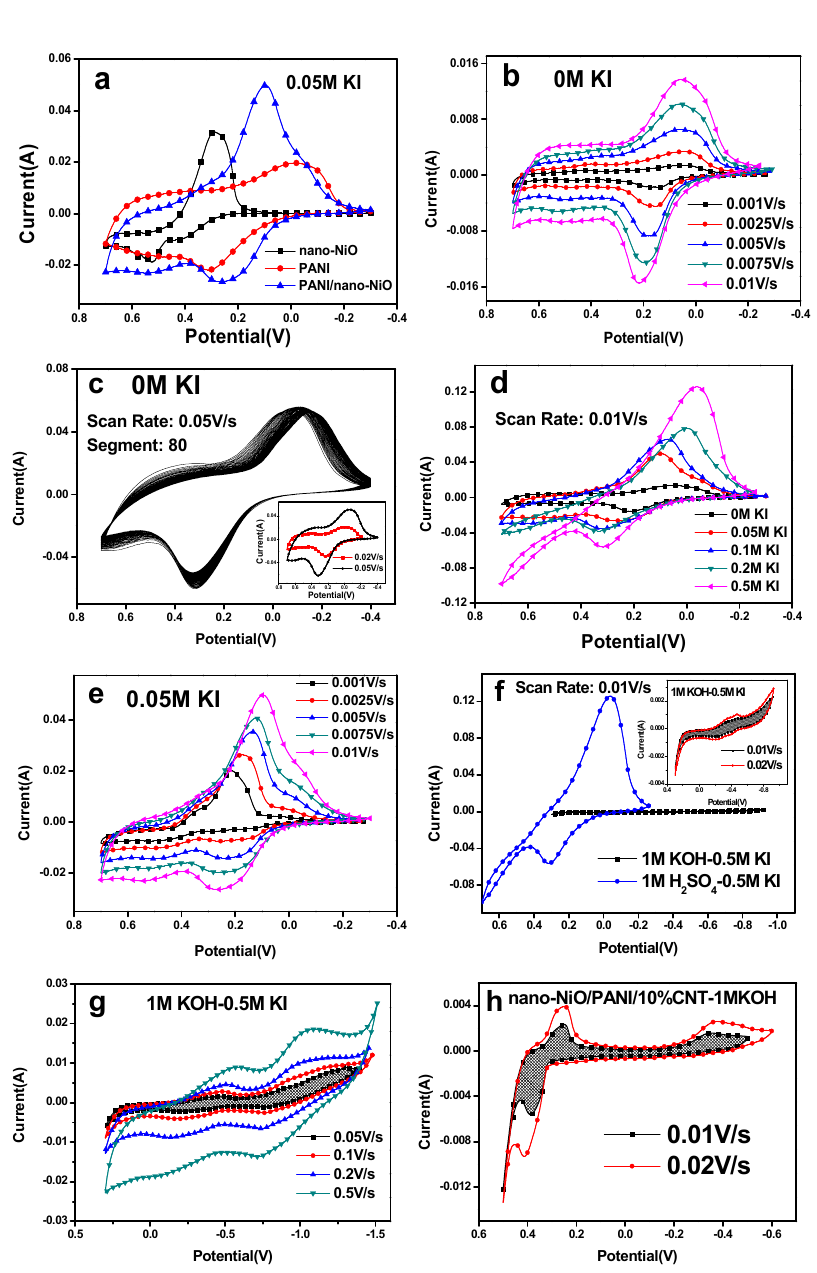
Figure 6. CV curves in different electrolytes, scan rates and concentration of KI. ( a ) 0.05 M KI, 0.01 V/s. ( b ) 0 M KI, 0.001–0.01 V/s. ( c ) 0 M KI, 0.05 V/s. ( d ) 0–0.5 M KI, 0.01 V/s. ( e ) 0.05 M KI, 0.001–0.1 V/s. ( f ) 0.5 M KI, 0.01 V/s. ( g ) 0.5 M KI, 0.05–0.5V/s. ( h ) 0 M KI, 0.01 and 0.02 V/s.